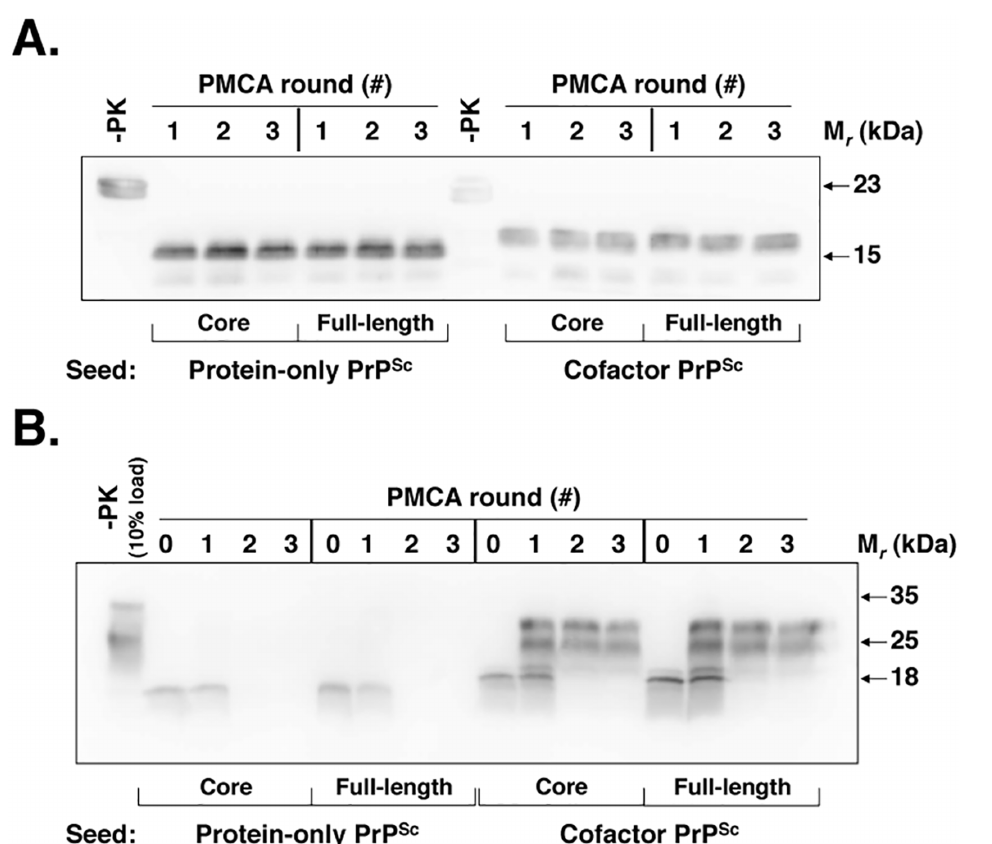
Fig 1. Cofactor and protein-only PrP Sc are stably propagating recombinant PrP conformers that differ in their ability to template the conversion of native PrP C . ( A ) Western blot showing three-round sPMCA reactions using recombinant PrP as the substrate and seeded with full-length or PK-digested cofactor and protein-only PrP Sc , as indicated. ( B ) Western blot showing three-round sPMCA reactions using normal mouse brain homogenate as the substrate and seeded with full-length or PK-digested cofactor and protein-only PrP Sc , as